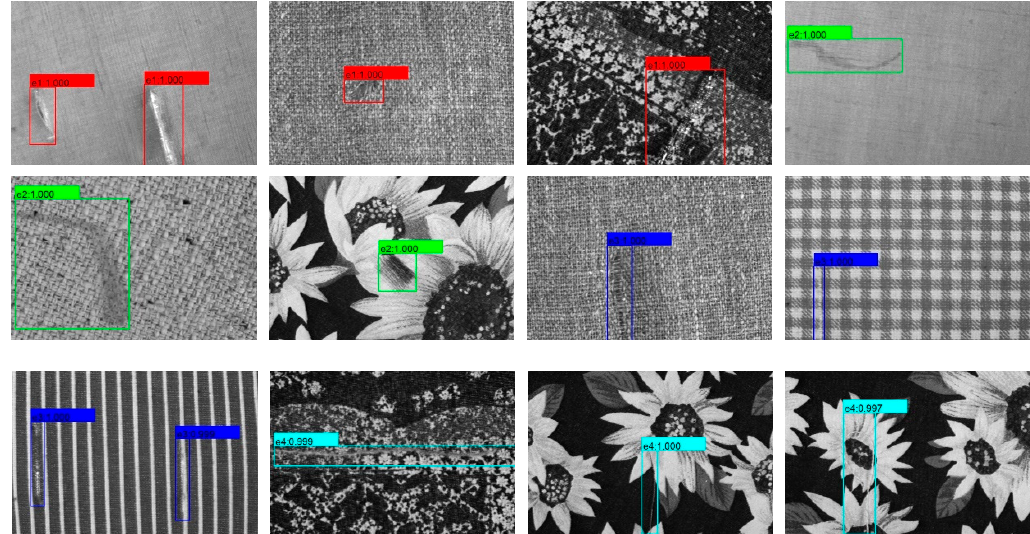
Figure 11. The detection result of the proposed method on the TILDA testing set.